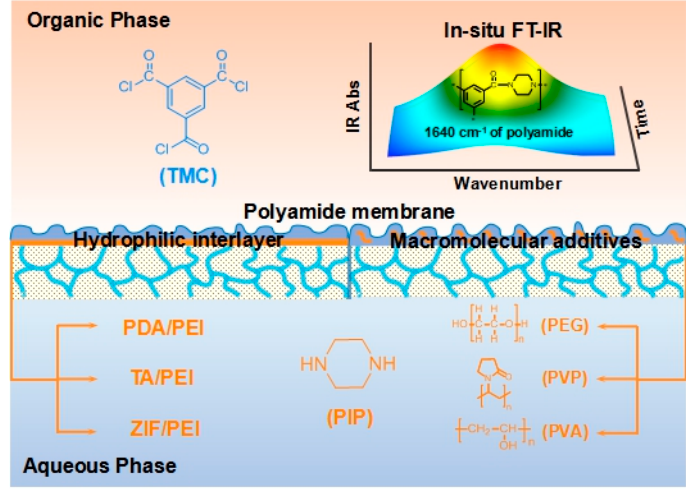
Figure 1. In-situ Fourier transform infrared (FT-IR) spectroscopy monitoring the interfacial polymerization (IP) reaction of piperazine (PIP)/trimesoyl chloride (TMC) by the introduction of hydrophilic interlayers on the pristine polysulfone (PSf) substrate or macromolecular additives in the aqueous solution of PIP. PDA: polydopamine (PDA), PEI: polyethyleneimine, TA: tannic acid, ZIF: zeolitic imidazolate framework, PEG: polyethyleneglycol, PVP: polyvinylpyrrolidone, PVA: polyvinyl alcohol.